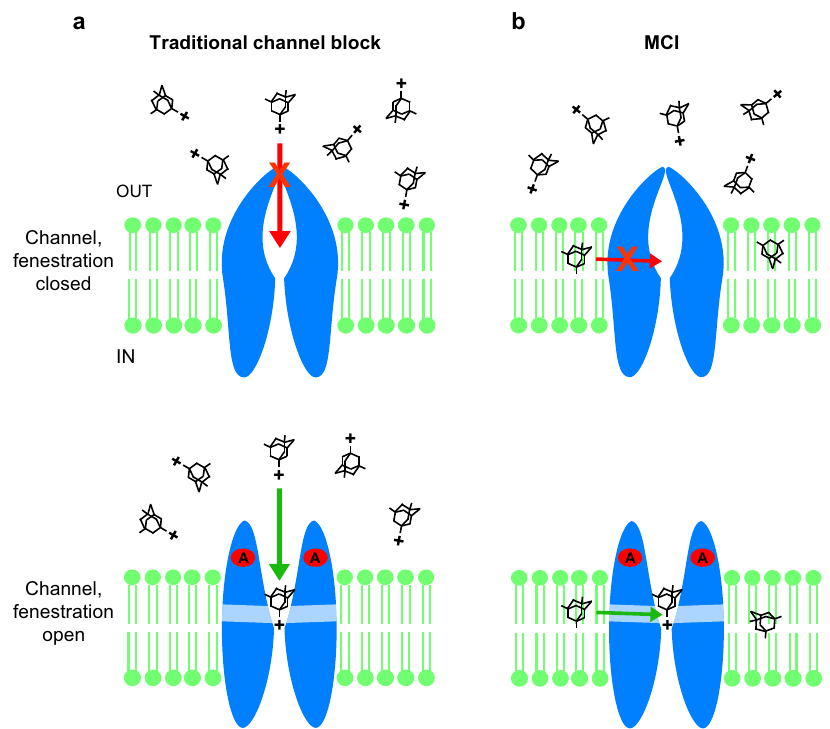
Fig. 7 The two paths by which memantine can access the deep channel blocking site in NMDARs. a Traditional channel block path. Top, charged memantine in the extracellular solution cannot access the deep site when the channel is closed. Bottom, charged memantine in the extracellular solution can transit to the deep site through the channel after agonists (A) bind and the channel gate opens. b MCI path. Top, uncharged memantine in the membrane cannot access the deep site when the membrane to channel fenestration is closed. Bottom, uncharged memantine in the membrane (shown here shortly after extracellular memantine has been washed away) can transit to the deep site through the gated fenestration after agonists bind and the fenestration